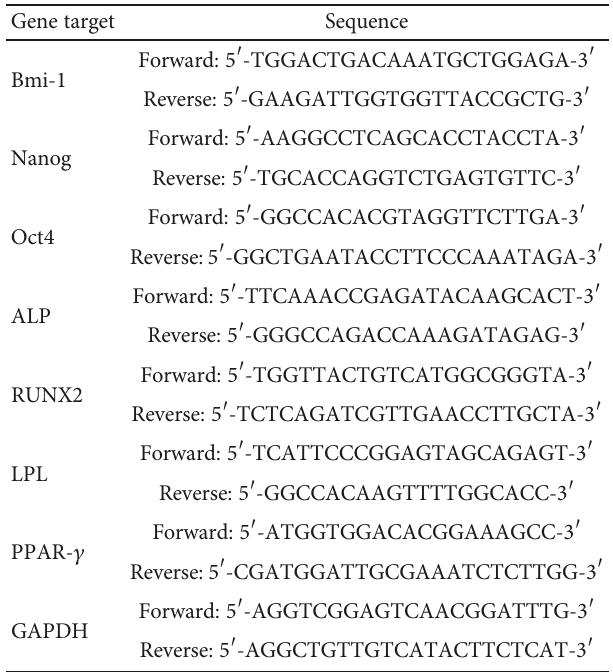
Table 1: Primer sequences used in quantitative real-time reverse transcription polymerase chain